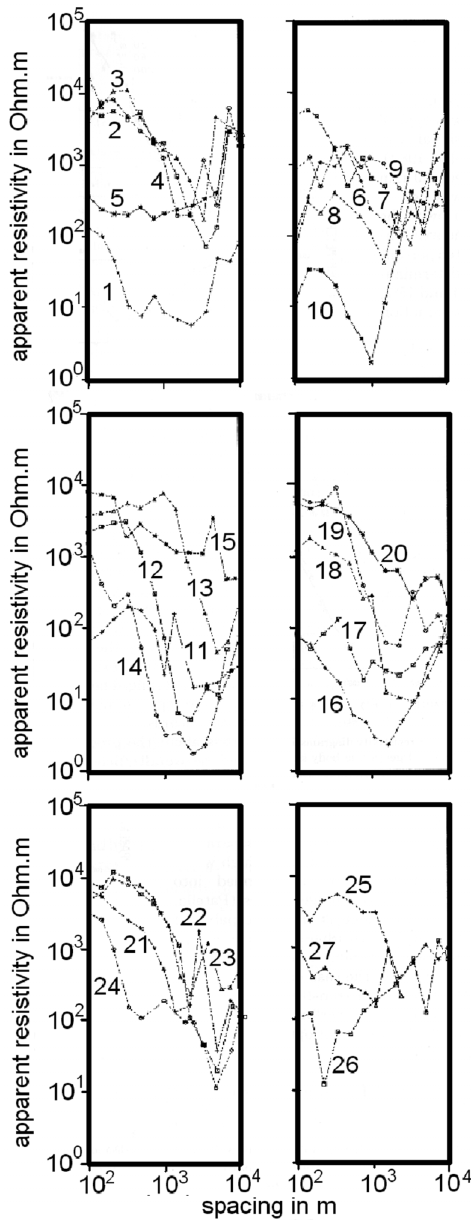
Fig. 12. The Mt. Etna case-history. The dipole geo- electrical sounding curves (redrawn after Loddo et al ., 1989). The number close to each curve indicates the sounding centre reported in fig.